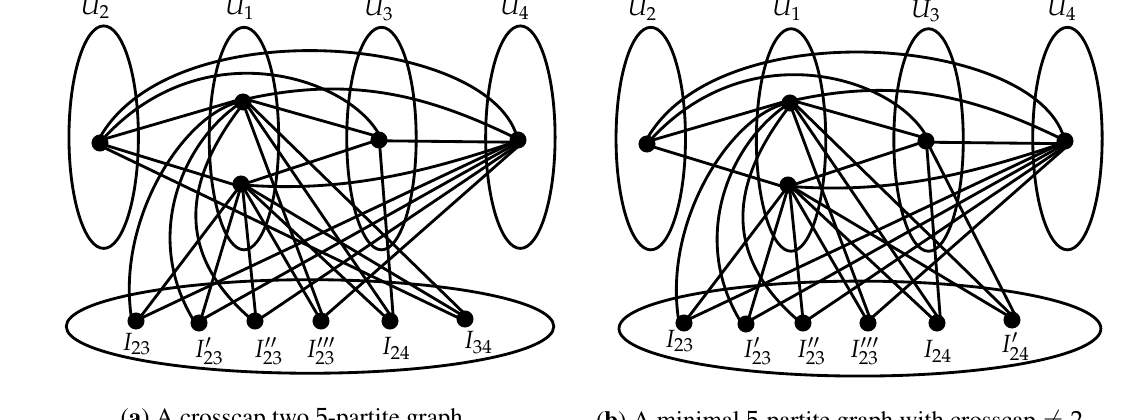
Figure 17. 5-partite graphs. Figure 18. Five-partite